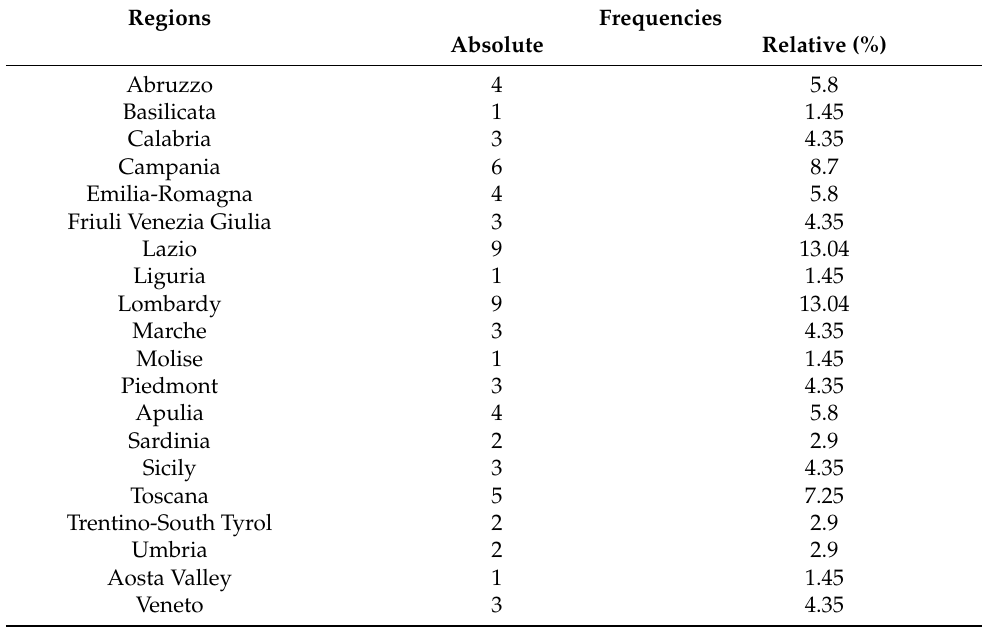
Table 2. Distribution of the sample by region of belonging. Regions